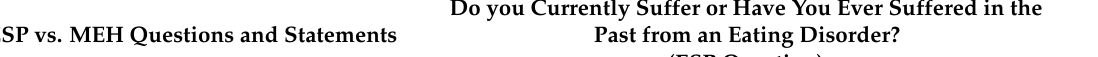
Table 11. The distribution of responses selected from the “My Eating Habits” questionnaire in accordance with behaviors typical for people with anorexia nervosa in males.